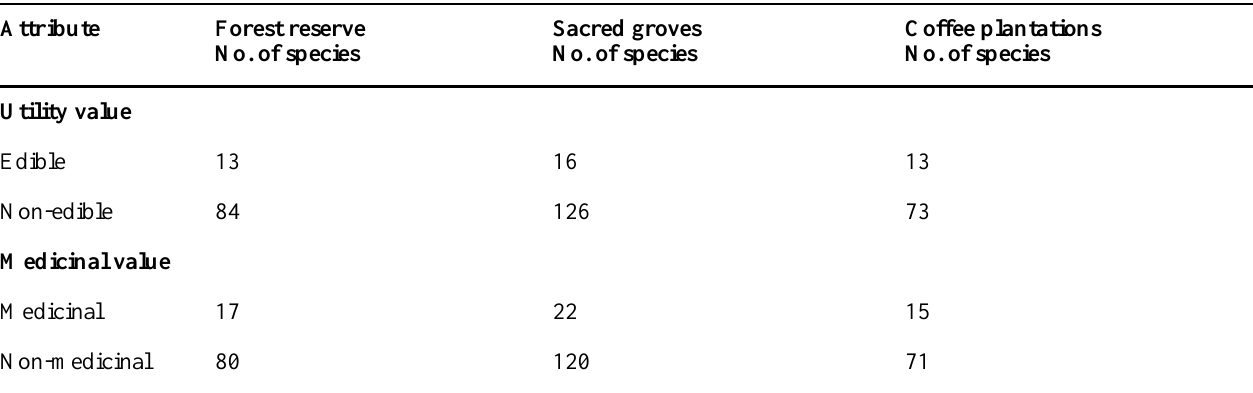
Table 4. The distribution of macrofungal sporocarps with and without utility value to the local people of Kodagu, Western Ghats of India